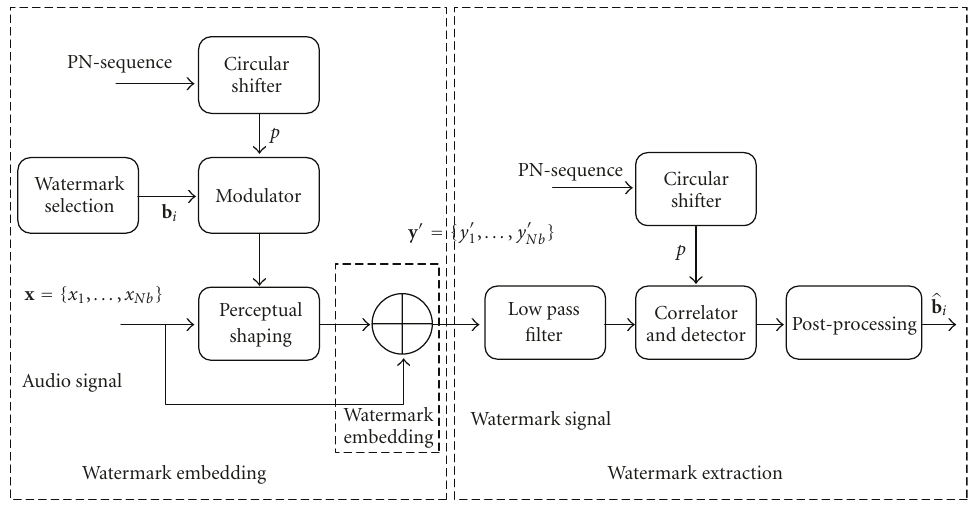
Figure 19: Watermark embedding and detecting